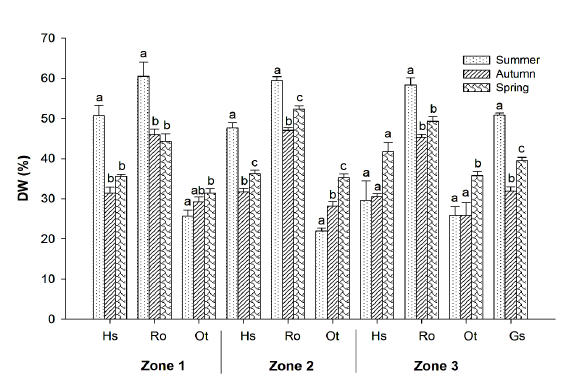
Fig. 2. Dry weight percentages (with respect to fresh weight) of the investigated taxa, in the three plots under study in summer 2009, autumn 2009 and spring 2010. Different letters indicate seasonal significant differences within each species and plot. Species